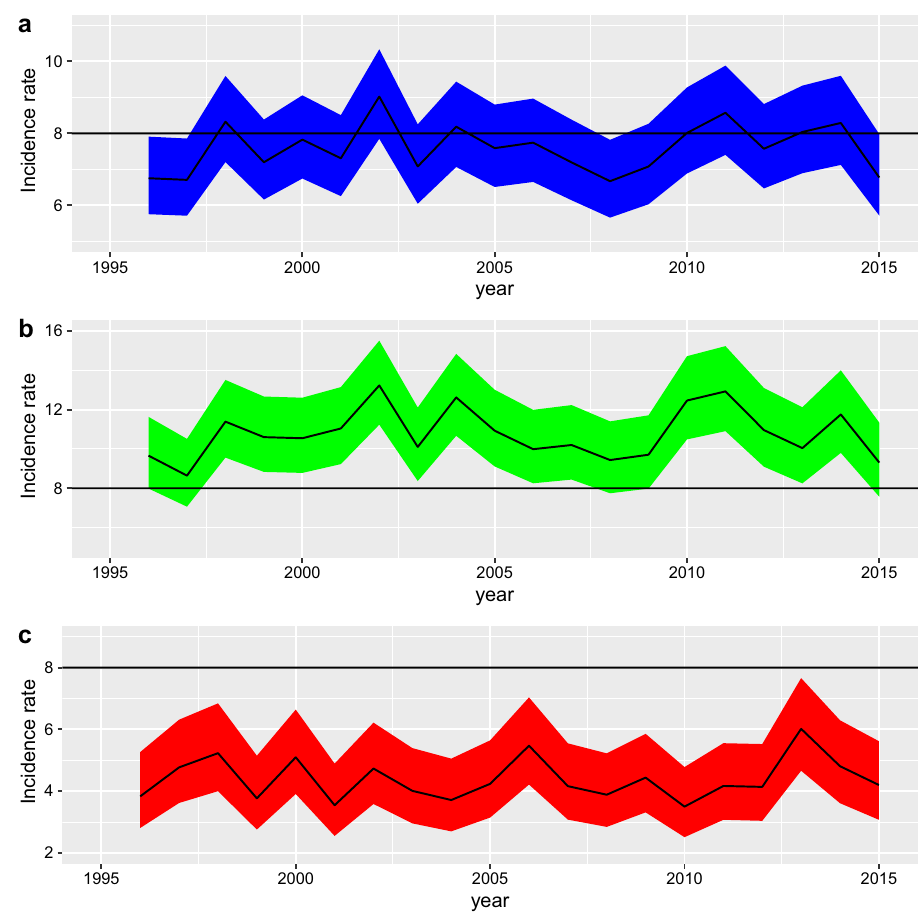
Figure 1. Change in overall annual sex- and age-standardized incidence of multiple sclerosis per 100,000 inhabitants in Lorraine from 1996 to 2015 ( a ), with 95% confidence intervals, and by sex standardized on age for women ( b ) and men ( c ), with 95% confidence